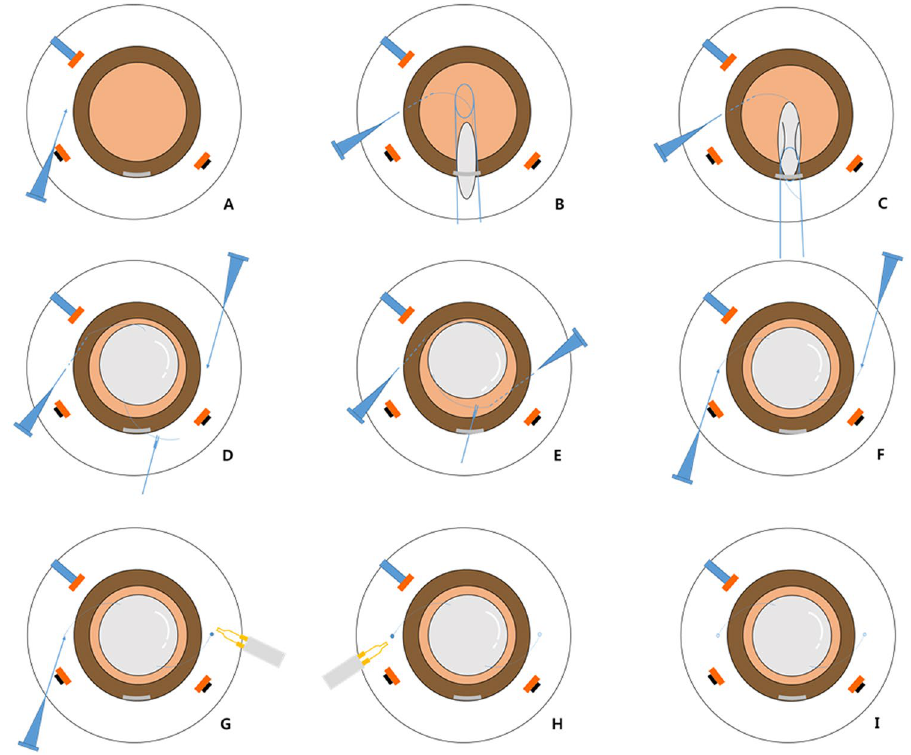
Figure 2. Step-by-step schematic illustration of the Simply Modified Intrascleral Fixation Using Round Flange (SMURF) technique. ( A ) An oblique (with an angle of 30° with respect to the limbus) angled (less than 5°–10° with respect to the surface of the iris) sclerotomy was performed 2.0 mm from the limbus using a conventional 27-gauge non-bent needle. A clear corneal incision should be made in the 12 o’clock to 1 o’clock direction before sclerotomy. ( B ) An intraocular lens (IOL) injector was introduced into the anterior chamber (AC), and IOL was injected slowly. When the tip of the leading haptic was initially shown in the AC, the left hand was moved from the screw mechanism plunger to the 27-gauge needle. The tip of the leading haptic was directly threaded into the 27-gauge needle and the angle of the bevel of the 27-gauge needle and tip of the haptic were adjusted. ( C ) The entire optic was injected into the AC after the anchoring of the leading haptic. At this point, the trailing haptic should be left at the corneal incision site to prevent drop of the IOL. ( D ) A second oblique sclerotomy was performed. At this point, the surgeon should confirm that the direction of both the 27-gauge needles is parallel and symmetrical. If not, the angle of the second sclerotomy should be adjusted. Then, the trailing haptic should be grasped with retinal forceps at the distal one-third point of the haptic. ( D , E ) The trailing haptic should be pushed into the AC using retinal forceps with the left hand and threading simultaneously with the second needle. If the trailing haptic could not be well-pushed into the AC, the grasping point should be adjusted. If the grasping is distal, the haptic does not easily insert into the AC. Grasping the proximal part of the haptic leads to difficulties in threading the haptic into the needle, although the haptic could be easily inserted into the AC. When using intraocular forceps on the left hand, the right hand should grasp the second needle to be threaded simultaneously. ( F ) Both haptics were externalised. ( G ) The tip of the trailing haptic was cauterised to create flanges. ( H ) The ends of the leading haptics were cauterised. I. Both flanged ends of the haptics were buried